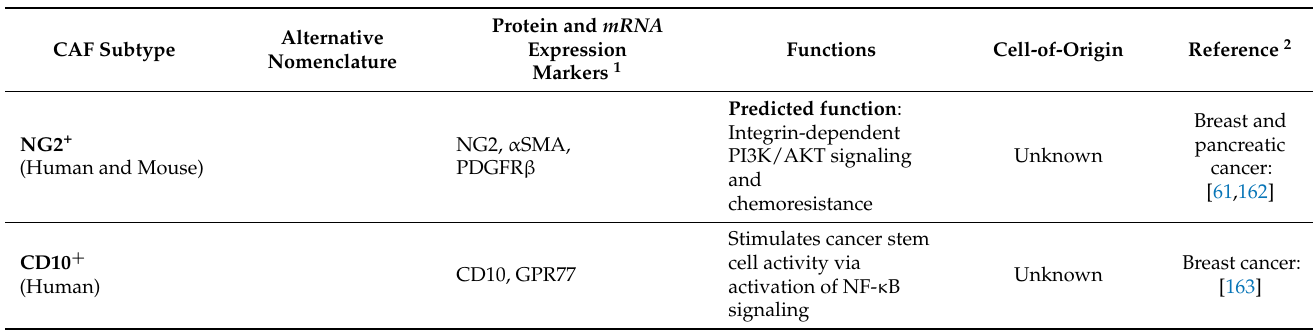
1 Gray text = expression marker identified but not consistently expressed. 2 Bold references = literature specific to prostate cancer. α SMA ( ACTA2) = alpha smooth muscle actin; AKT ( PBK) = protein kinase B; AR = androgen receptor; ASPN = asporin; CAV1 = Calveolin-1; CCL2 = C-C motif chemokine ligand 2; CD26 = Dipeptidyl pepti- dase; CD29 = Integrin β 1; CD30 = TNF receptor superfamily member 8; CD31 = Platelet endothelial cell